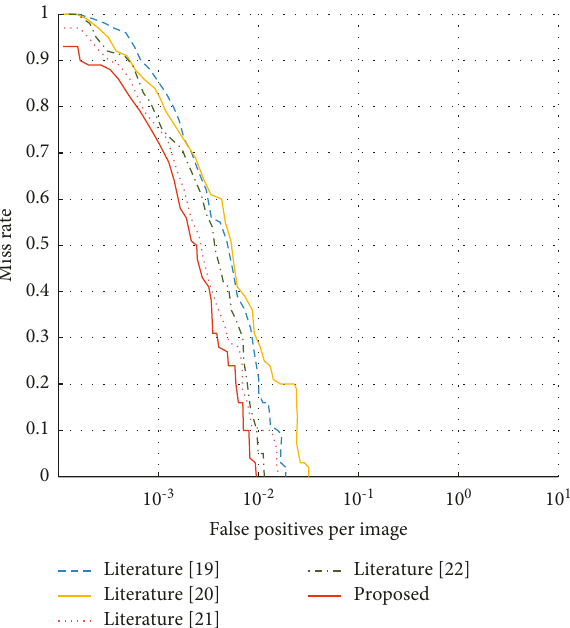
Figure 7: The MR-FPPI result of the MS COCO